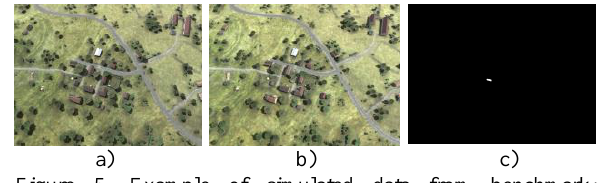
Figure 5. Example of simulated data from benchmark: a) reference image; b) test image; c) ground truth